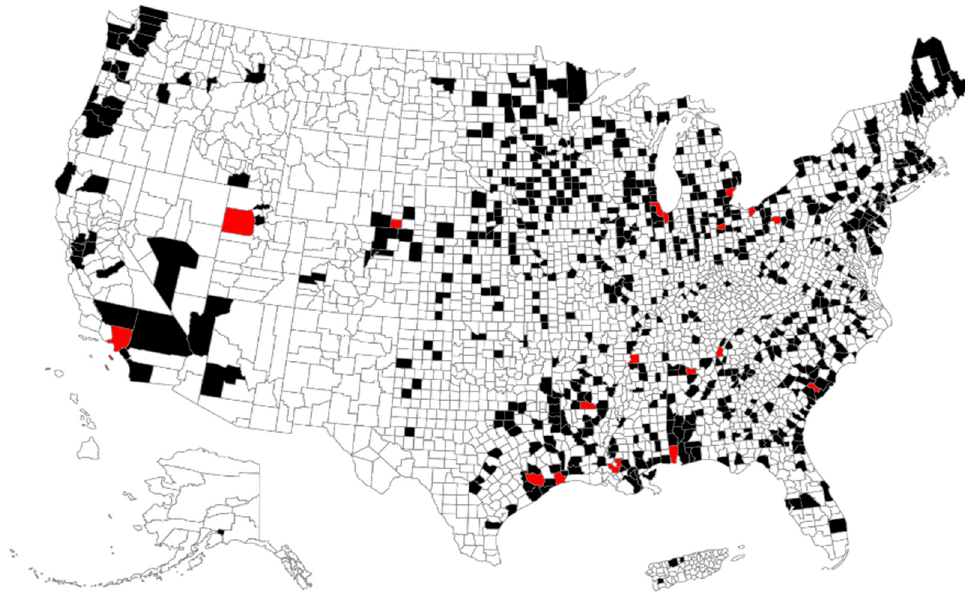
Figure 3. Counties (in black) with facility-level emissions between 2000 and 2018 (TRI) of formaldehyde and one or more respiratory carcinogens identified in the USEPA IRIS database. Counties shown in red have facility-level emissions of formaldehyde and nine or more IRIS-assessed respiratory carcinogens.